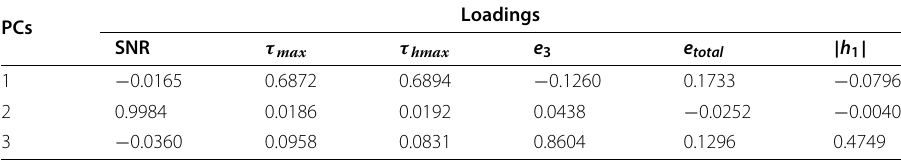
Table 7 Loadings of retained PCs after DR (TrainingIdx